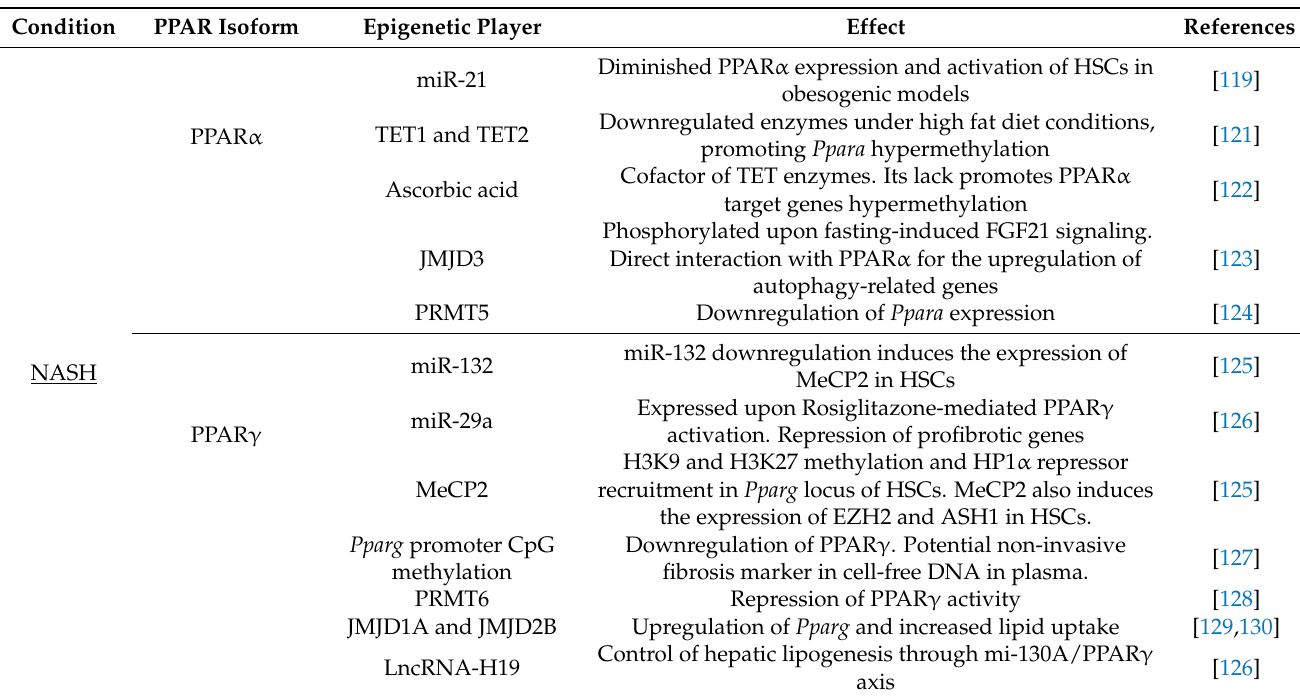
Table 3. PPAR epigenetics in non-alcoholic